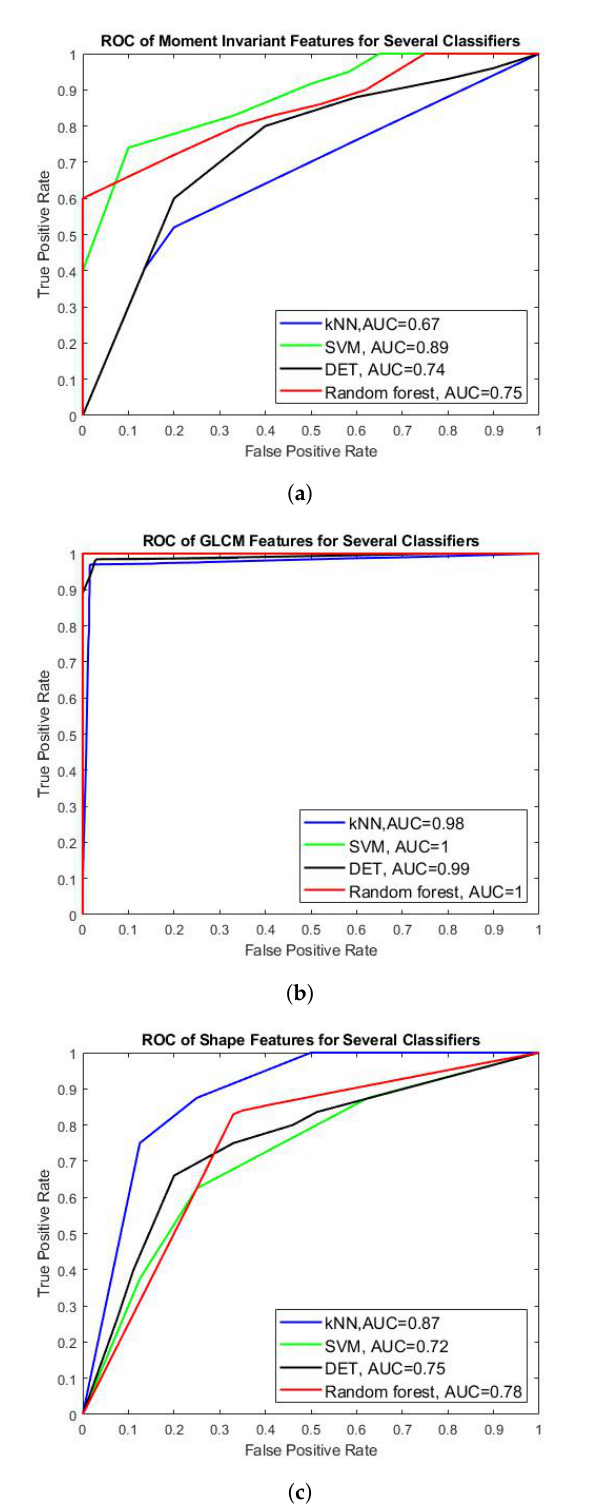
Figure 11. AUC-ROC curves for ( a ) Moment invariants, ( b ) GLCM, and ( c ) shape